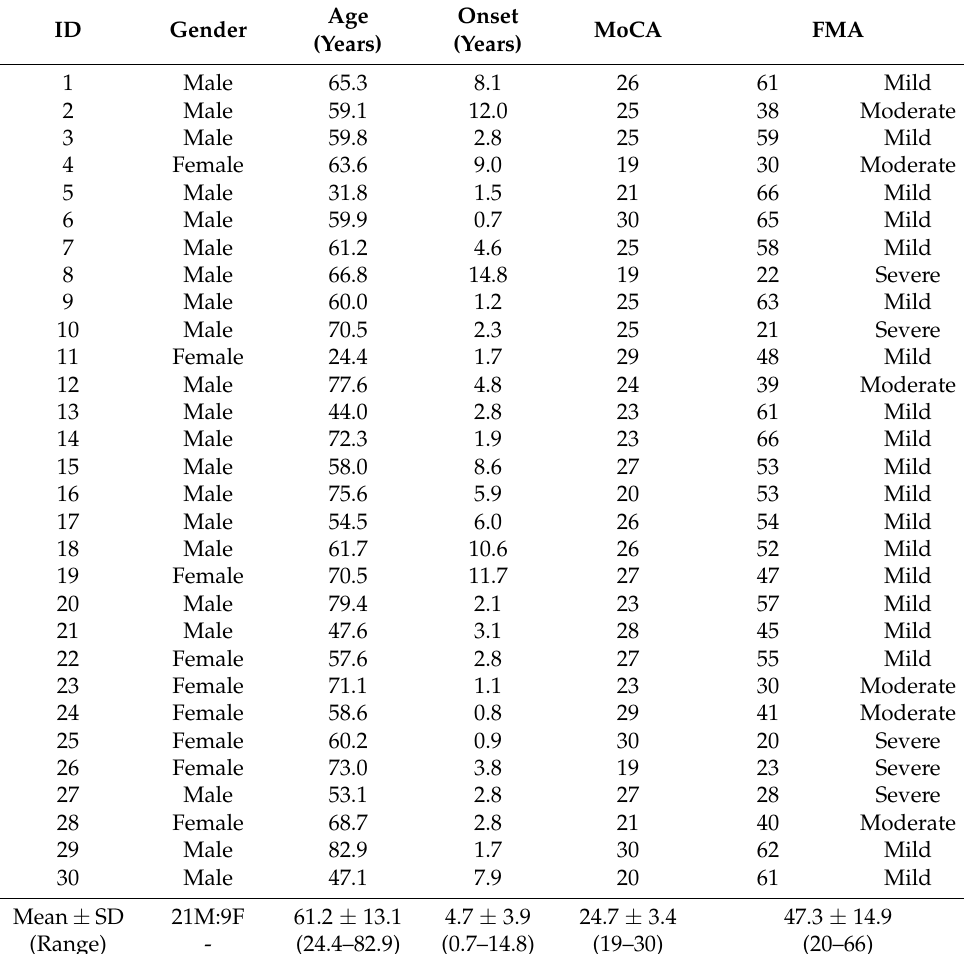
Table 1. Characteristics of Participants ( n =